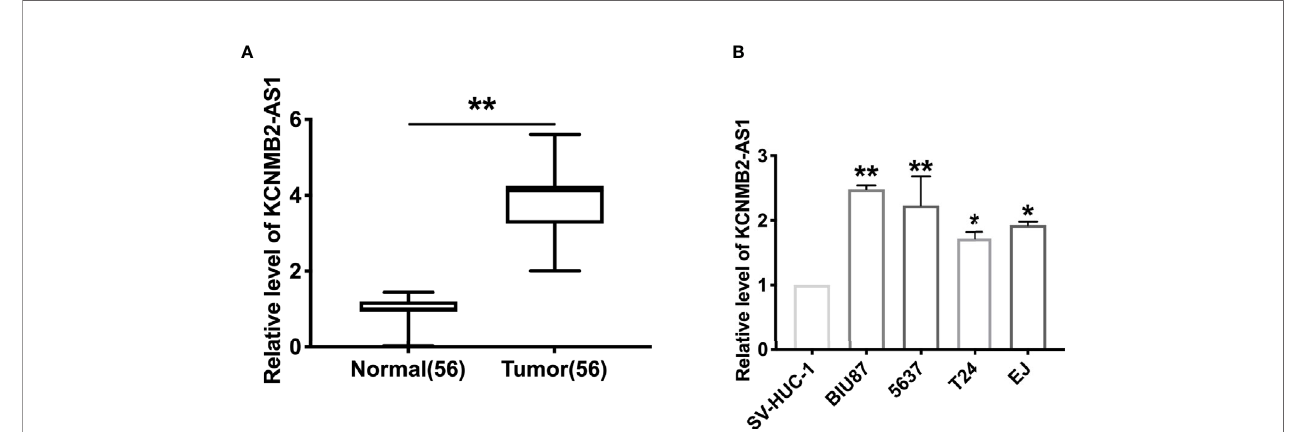
FIGURE 1 | The increased expression of KCNMB2-AS1 in bladder cancer. (A) KCNMB2-AS1 expression in 56 pairs of bladder cancer and adjacent normal tissues detected by qRT-PCR. (B) The expression of KCNMB2-AS1 in bladder cancer cell lines and the normal SV-HUC-1 cell line. n = 7. * P < 0.05, ** P